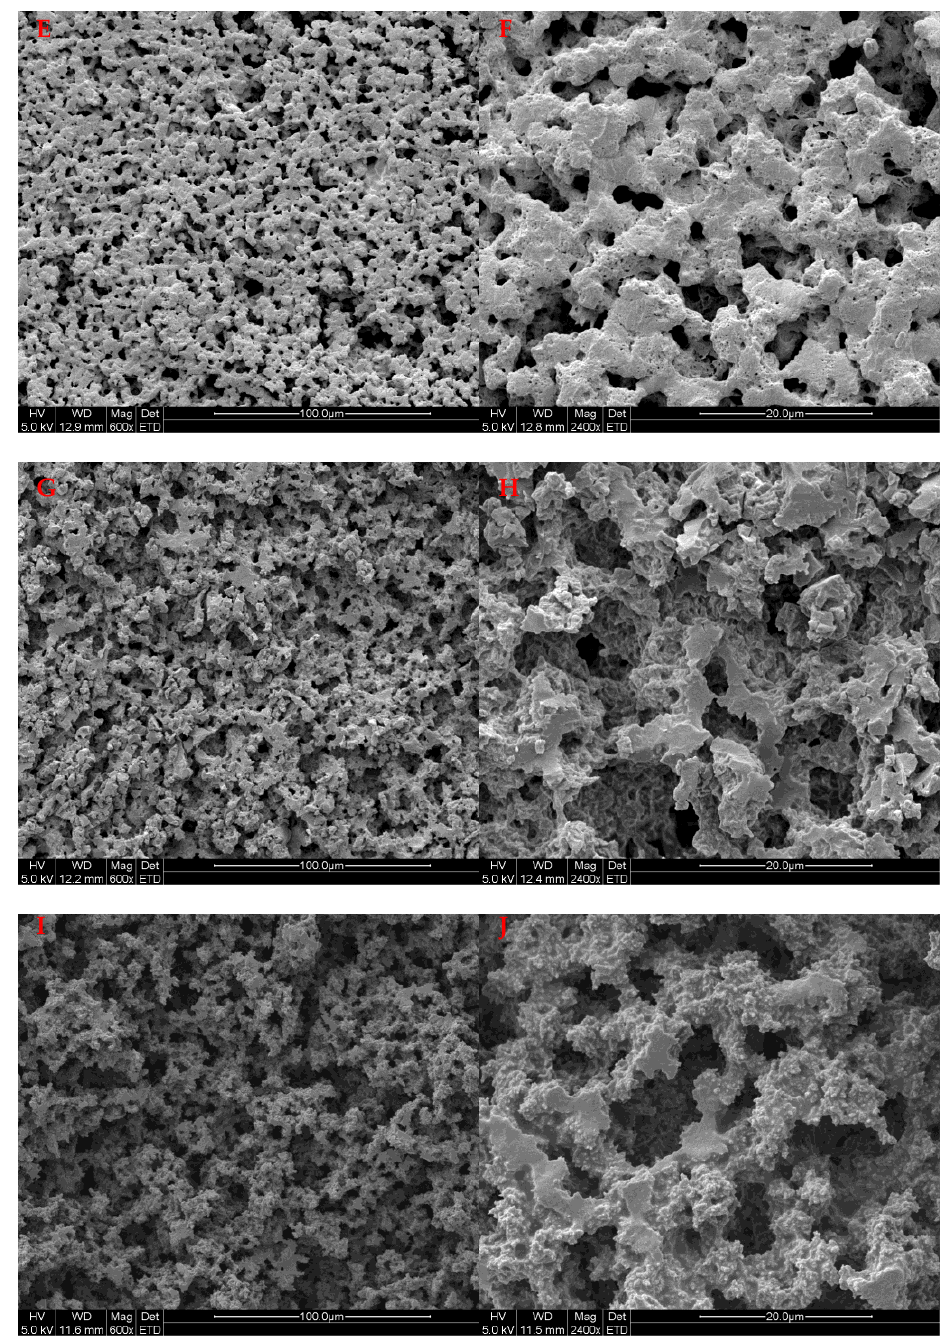
Figure 3. The morphology of lyophilized hydrogels: ( A , B ) Gel 1; ( C , D ) Gel 2; ( E , F ) Gel 3; ( G , H ) Gel 4; ( I , J ) Gel 5.